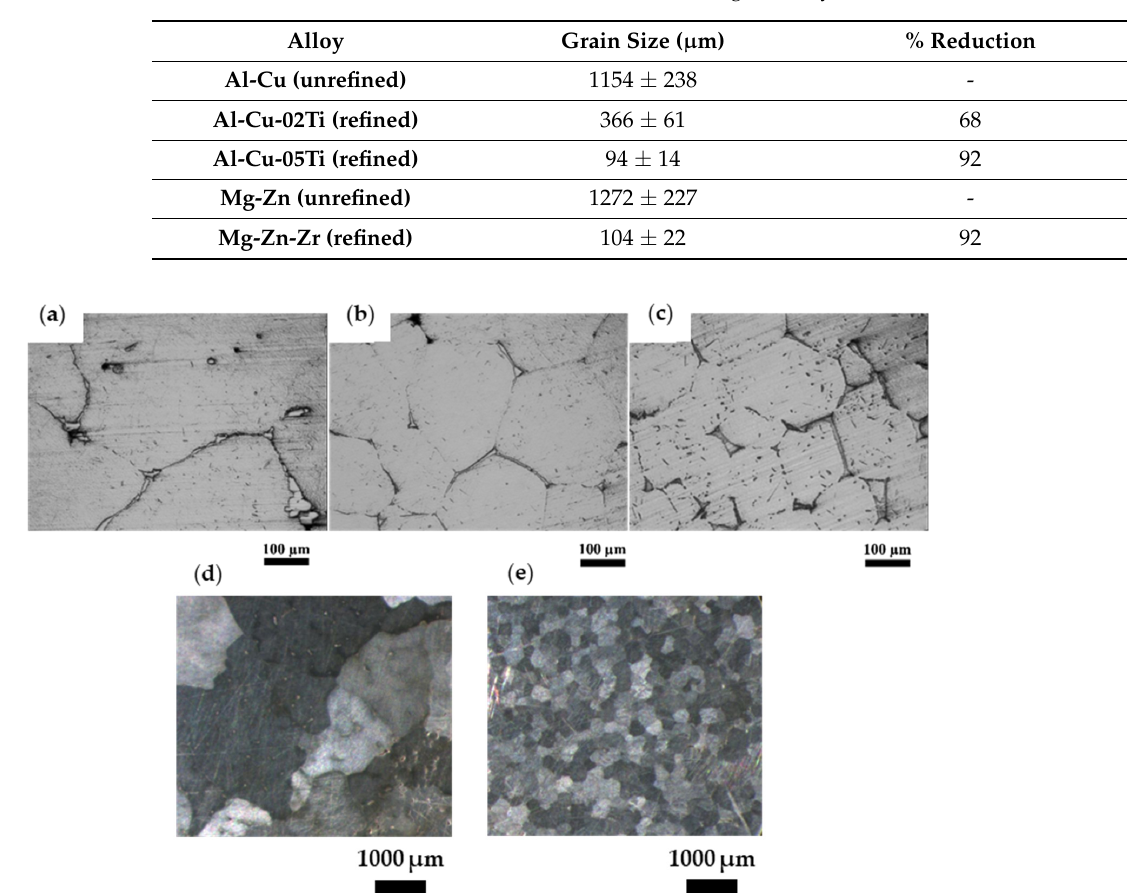
Table 2. Grain sizes of unrefined and refined Al-Cu and Mg-Zn alloys. Alloy Grain Size (µm)